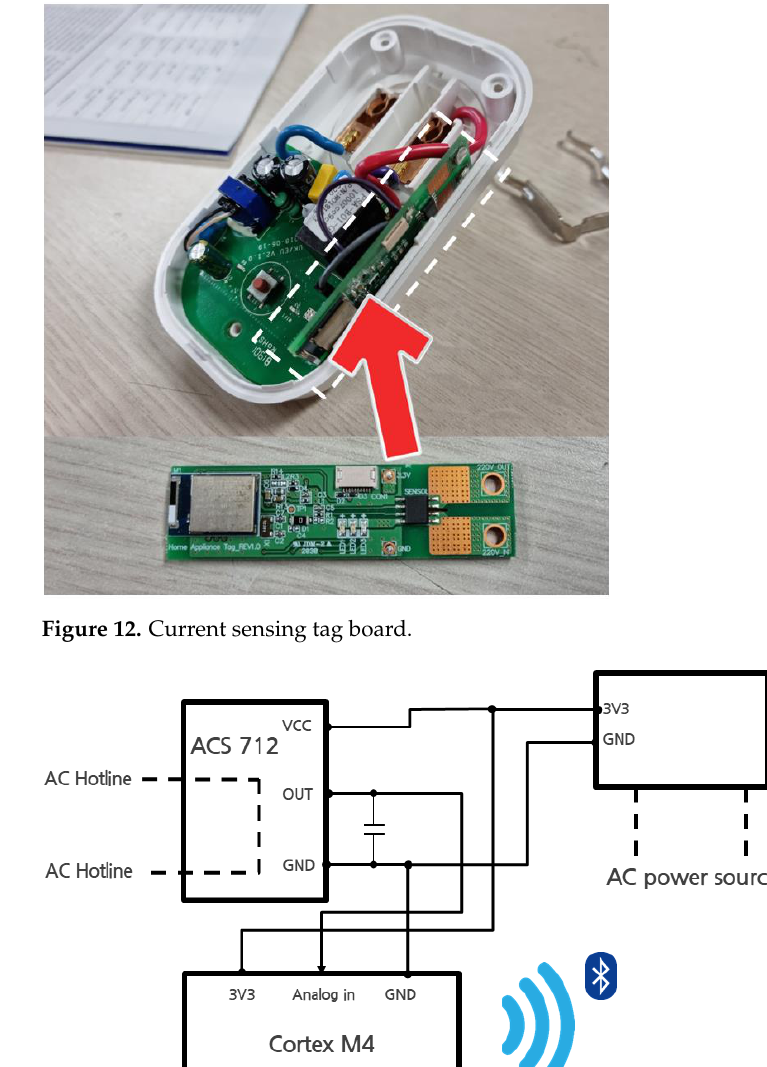
Figure 14. Event sequence of Current Sensing Tag.